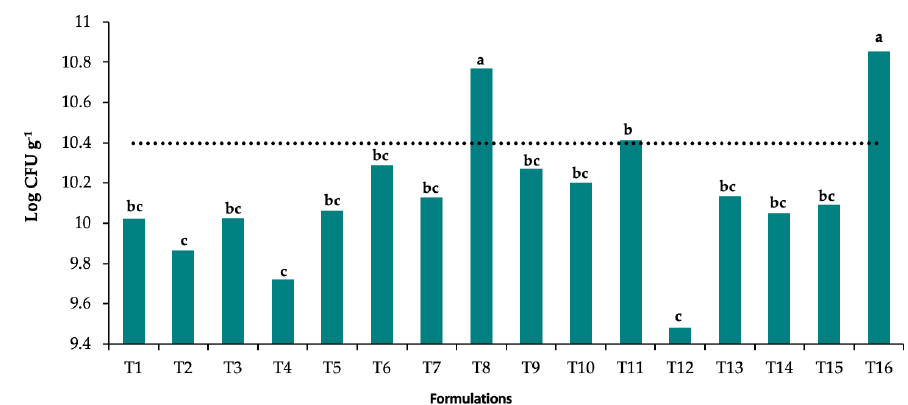
Figure 1. Viability of the TEP6 bacteria incorporated into films freshly prepared with different concentrations of Aloe vera and chitosan. The dotted line represents the initial number of cells added in solution (10.4 log CFU·g –1 ); the bars represent the number of cells in the different formulations of freshly processed dry films. The letters represent the analysis of variance.